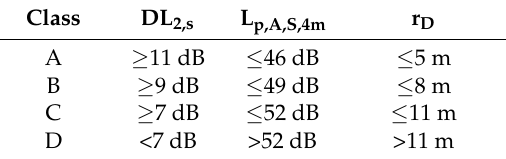
Table 1. Acoustic classification of open plan offices according to EN ISO 3382-3.